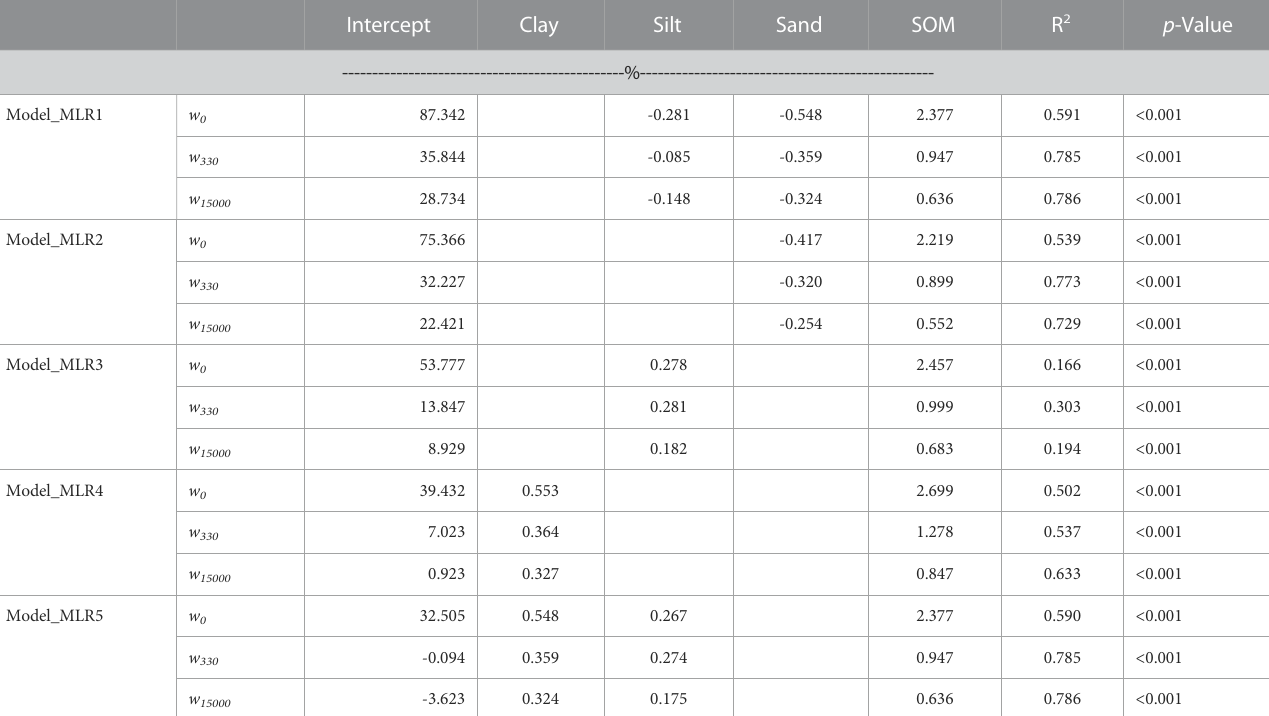
TABLE 6 Pedotransfer functions parameters using multiple linear